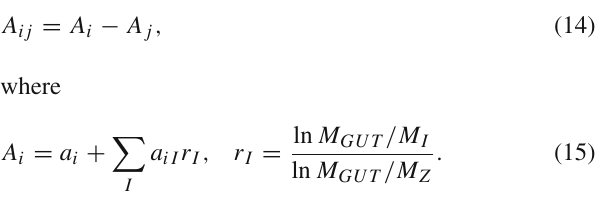
(cid:11) 10 16 . 3 E 6